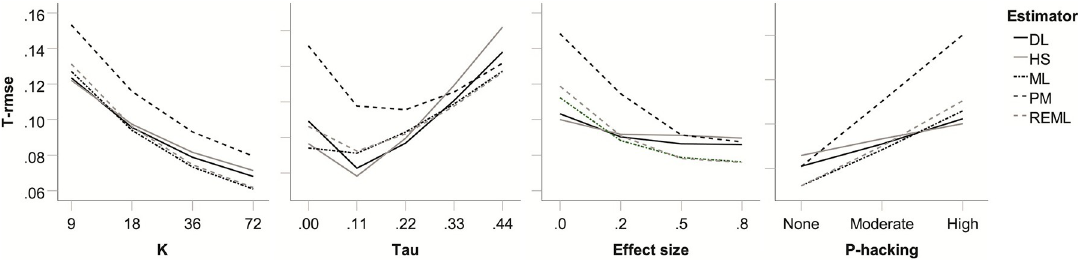
Fig 7. Root mean square error for heterogeneity estimates ( T RMSE ) for five heterogeneity estimators as a function of number of studies in the meta-analysis ( k ), true heterogeneity ( τ ) true average effect size ( θ ), and p -hacking environment, respectively.